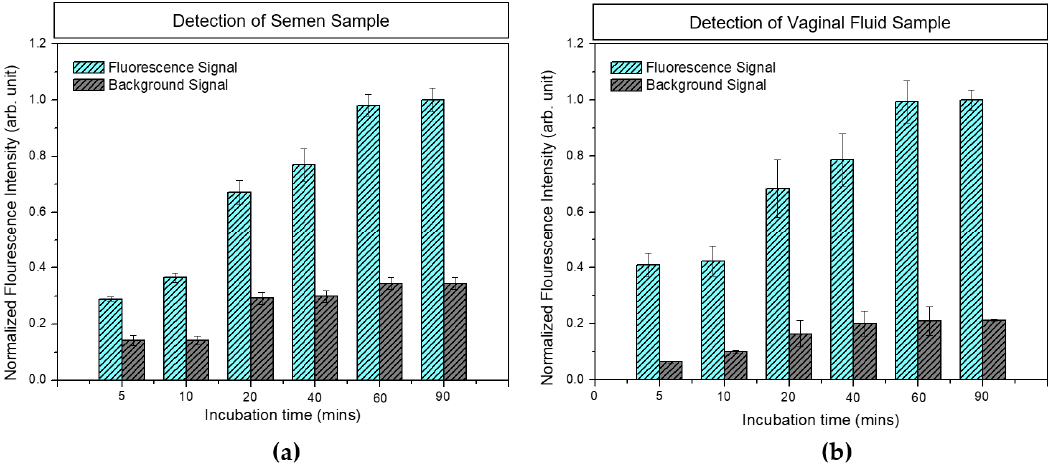
Figure 5. Effect of incubation time on the fluorescence signal for ( a ) the 12 μg/mL semen sample and ( b ) the 1 μg/mL vaginal fluid (VF) sample. ( b ) the 1 µ g/mL vaginal fluid (VF)